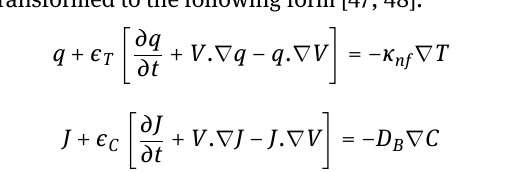
(3) transformed to the following form [47,